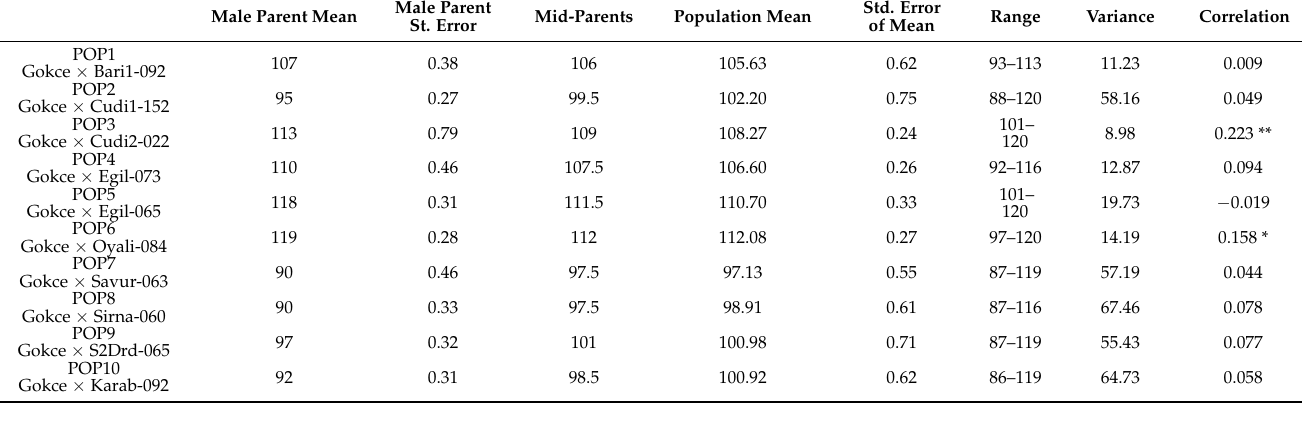
Table 2. Summary of flowering time observations for chickpea NAM populations. The female parent was Gokce (mean = 105, se = 0.09) and the male parent was the wild genotype in all populations. Correlations with flower color are shown. Correlations were insignificant unless followed by asterisks (* means p < 0.05, ** means p < 0.01).